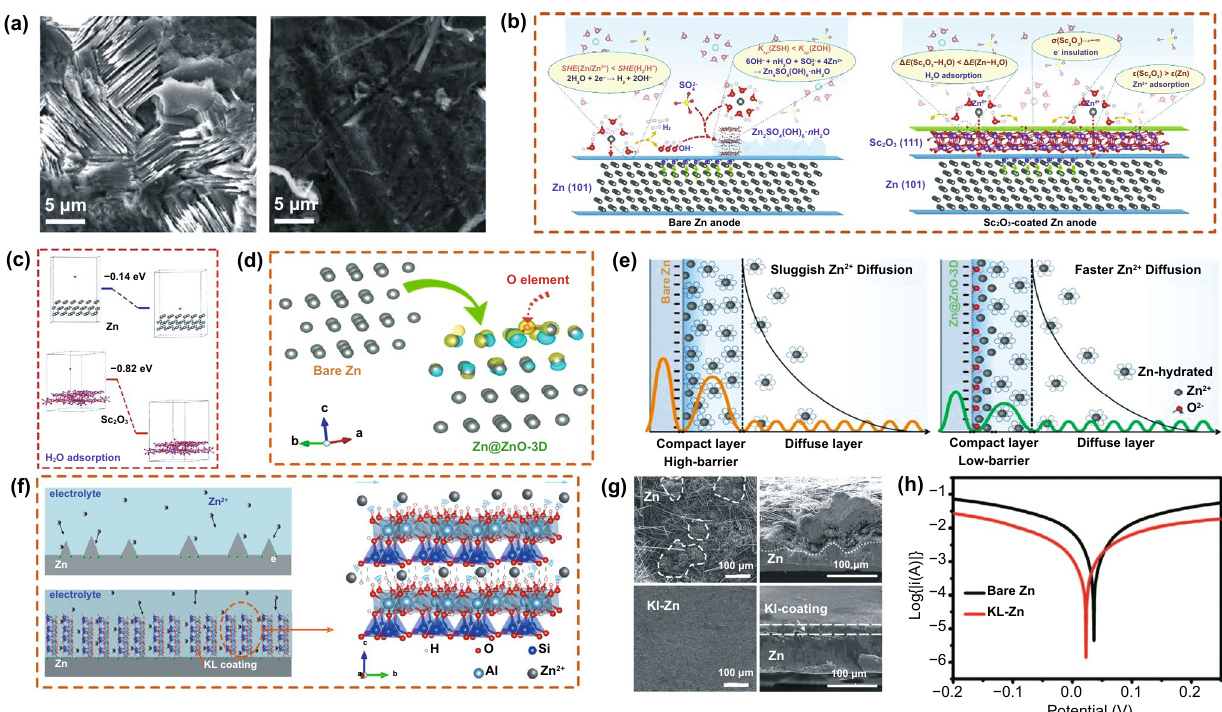
Fig. 8 a SEM images of bare Zn after cycling. Copyright 2020 Royal Society of Chemistry [96]. b Long-term cycling stability of bare Zn and 100Al 2 O 3 @Zn with a 200-µl electrolyte. c Schematic diagram of the reaction process on the surface of a bare Zn anode and Sc 2 O 3 -coated Zn anode. Copyright 2020 Elsevier [97]. d Differential charge density distribution of Zn@ZnO-3D calculated by first-principle calculations. e Elec- tric double-layer structure in the vicinity of the anode and the corresponding energy barrier. Copyright 2016 Royal Society of Chemistry [68]. f Schematic diagram of Zn 2+ deposition on the surface of naked Zn and KL-Zn and detailed schematic diagram of the limited Zn 2+ transport in kaolin. g SEM images of the surface and cross-sectional morphology of the KL-Zn anode after 600 cycles with a MnO 2 cathode under 0.5 A g −1 . h Linear polarization curves for the corrosion of bare Zn and KL-Zn. Copyright 2020 Wiley-VCH